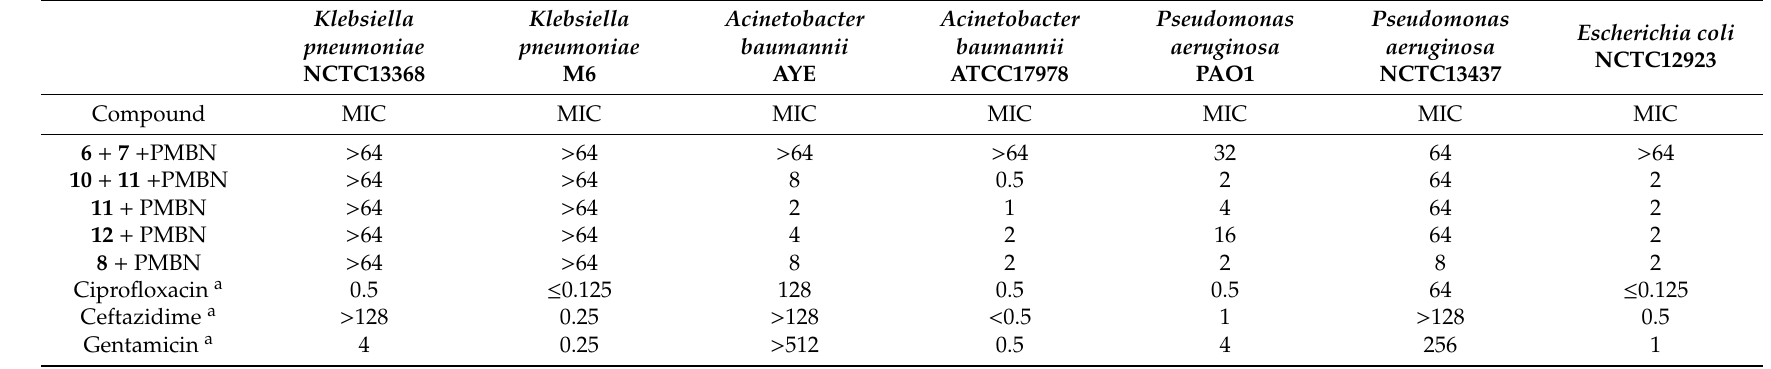
Table 6. Gram-negative MIC Values (in µ g / mL) of compounds 6 – 8 and 10 – 12 in the presence of the membrane permeabilizer polymyxin-B-nonapeptide at 30 µ g /